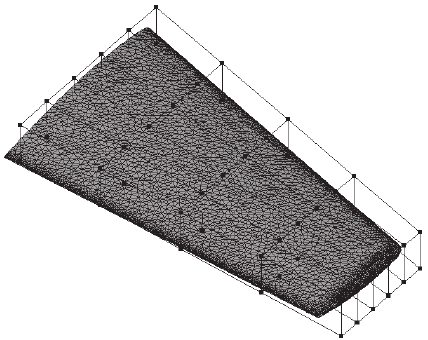
Figure 4: Surface mesh and FFD control volume of ONERA M6.